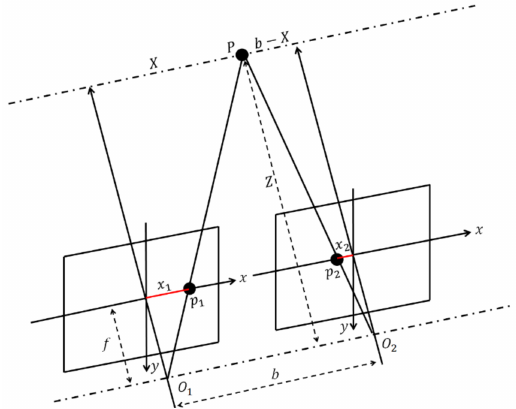
Figure 7. Triangulation scheme of stereo camera-like. The O 1 is camera plan 1 in the left side then shifting along baseline b and taken a picture in O 2 as camera frame of plan